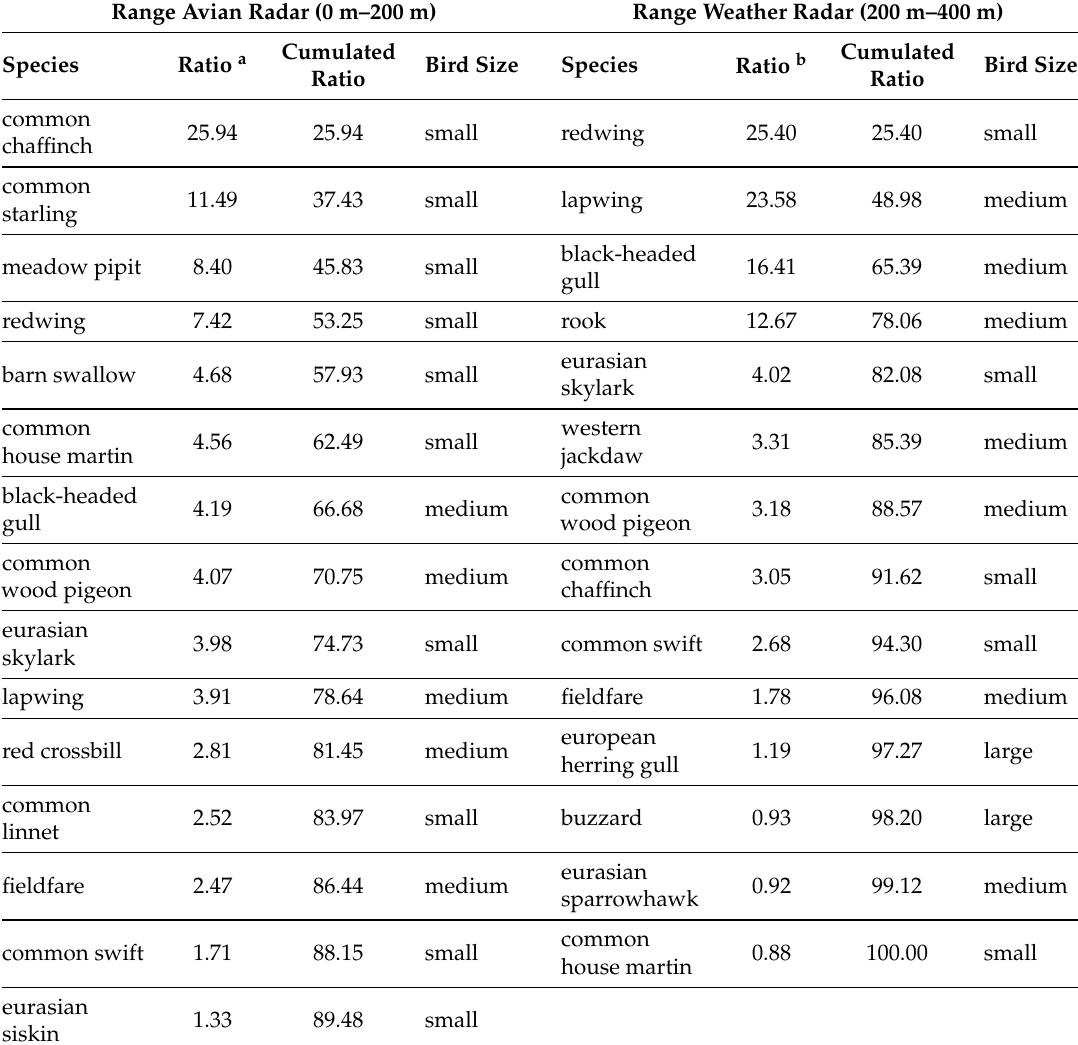
Table 1. Bird species chosen for modelling flock compositions. Source: